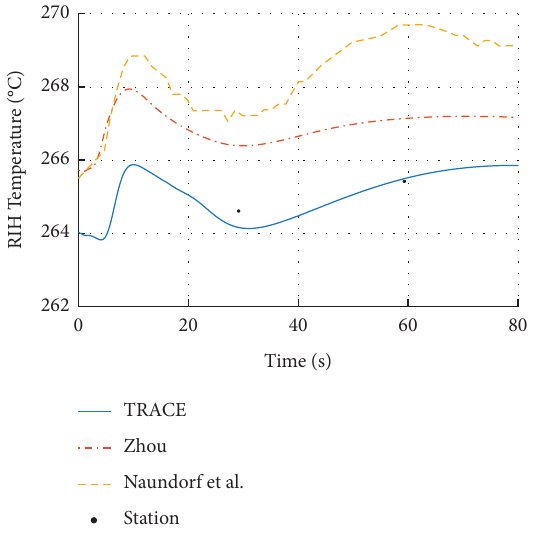
Figure 33: Reactor inlet header temperatures for the loss of flow event.